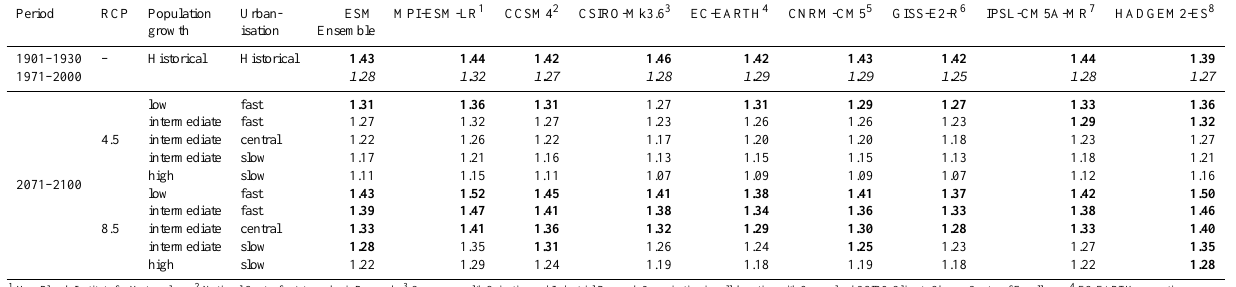
Table 2. Temporal average of global wildfire emissions in PgCyr − 1 by time period, scenario and ESM 9 .